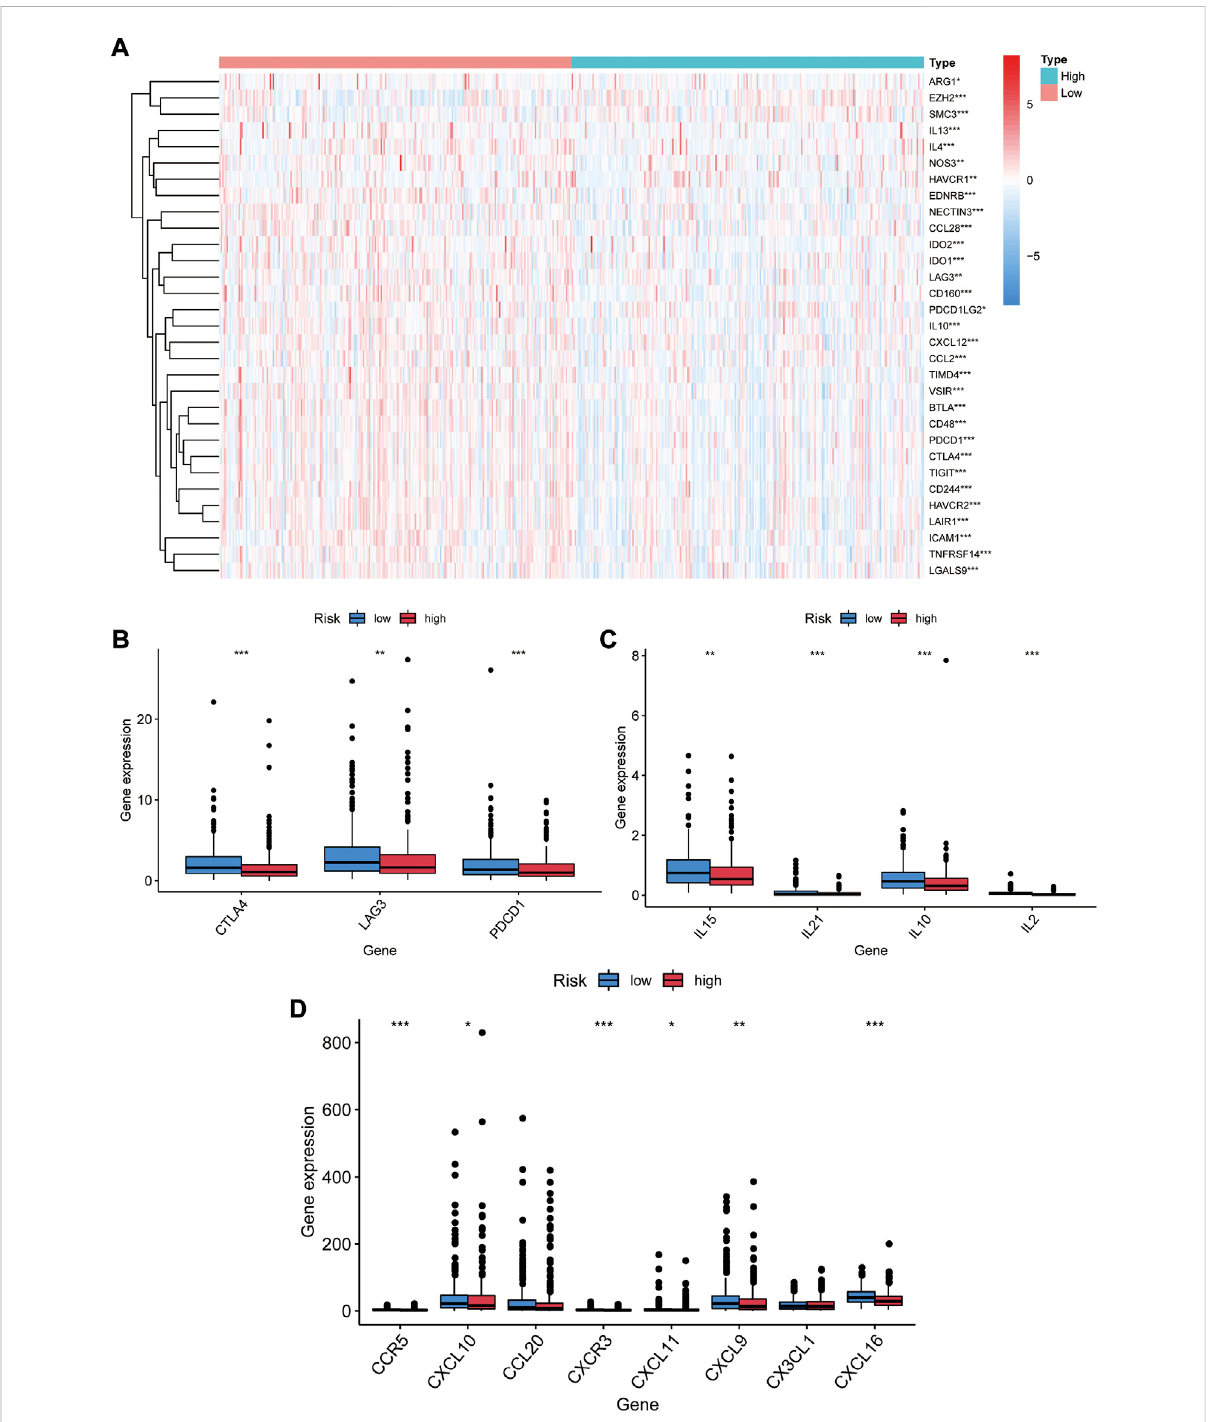
FIGURE 9 Immunecheckpointsandchemokinesexpressioninbothriskgroups. (A) Heatmapofgenepro fi lesassociatedwithtumor-promotingeffectsof both groups in the TCGA database. (B) Expression of CTLA-4, LAG3, PDCD1 in two groups. (C) Expression of IL15, IL21, IL10, IL2 in two groups. (D) Expression of CCR5, CXCL10, CCL20, CXCR3, CXCL11, CXCL9, CX3CL1, and CXCL16 in two groups. * p < 0.05, ** p < 0.01, *** p <